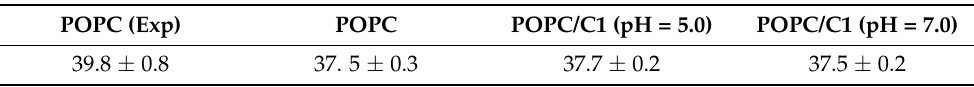
Table 2. Thickness of a POPC membrane in the absence and presence of the C1 probe at different pH values.